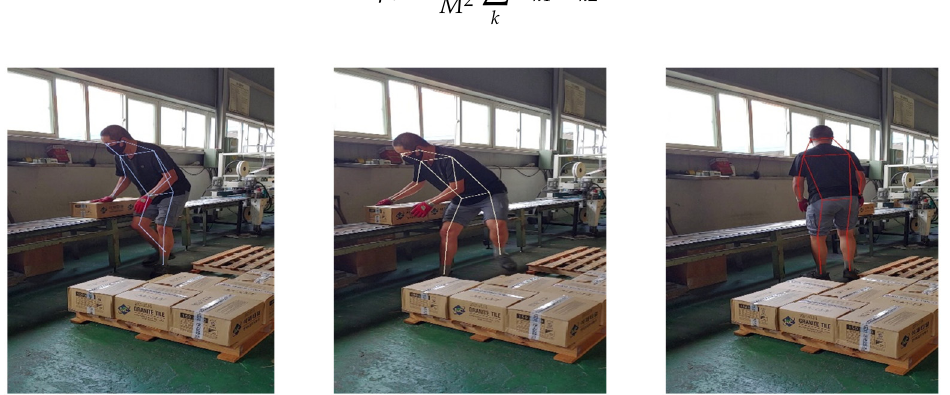
Figure 3. Good posture image with high reliability.